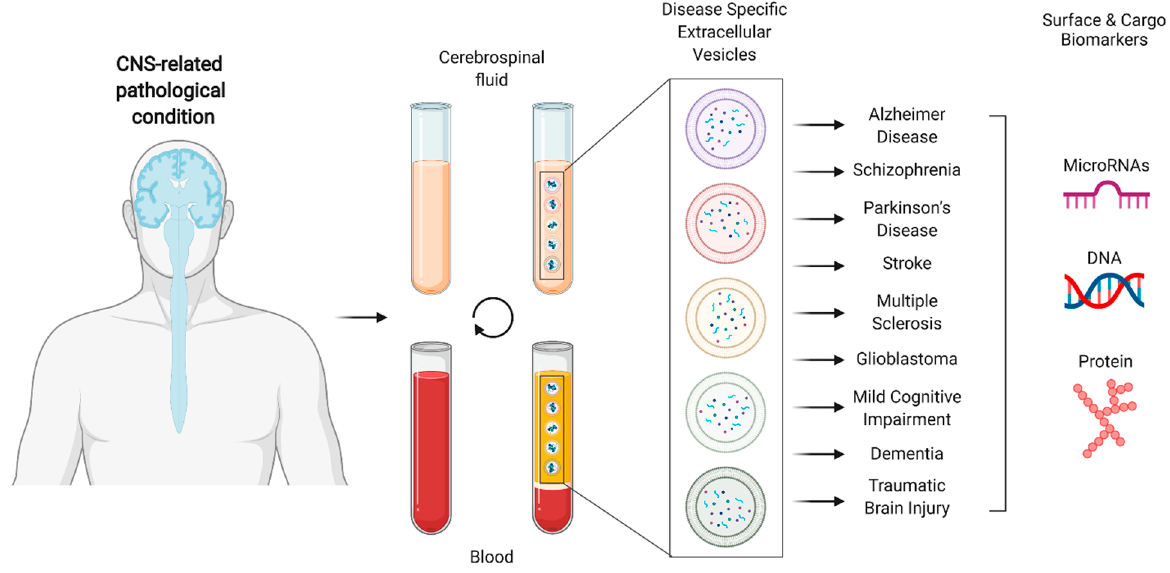
Figure 3. Schematic representation of the use of extracellular vesicles in liquid biopsies for identification of specific central nervous system (CNS)-related pathological conditions. Created with BioRender.com (accessed on 20 March 2021).